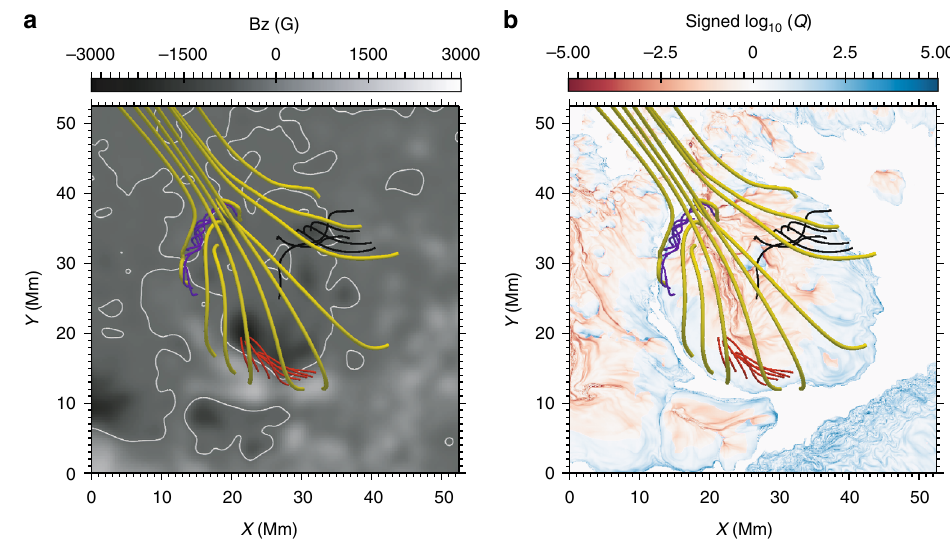
Fig. 6 Magnetic fi eld con fi guration of the fl are region. a Map of the photospheric vertical magnetic fi eld. White contours mark the polarity inversion line of the magnetogram. b Map of the squashing factor Q on the bottom boundary calculated from the nonlinear force-free fi eld. The sign of log 10 Q is taken from that of the corresponding magnetic polarity. Small fl ux ropes colored with blue, red, and black appear under the large dome structure colored with yellow in a , b . The fi eld of view is equivalent to that of Fig.